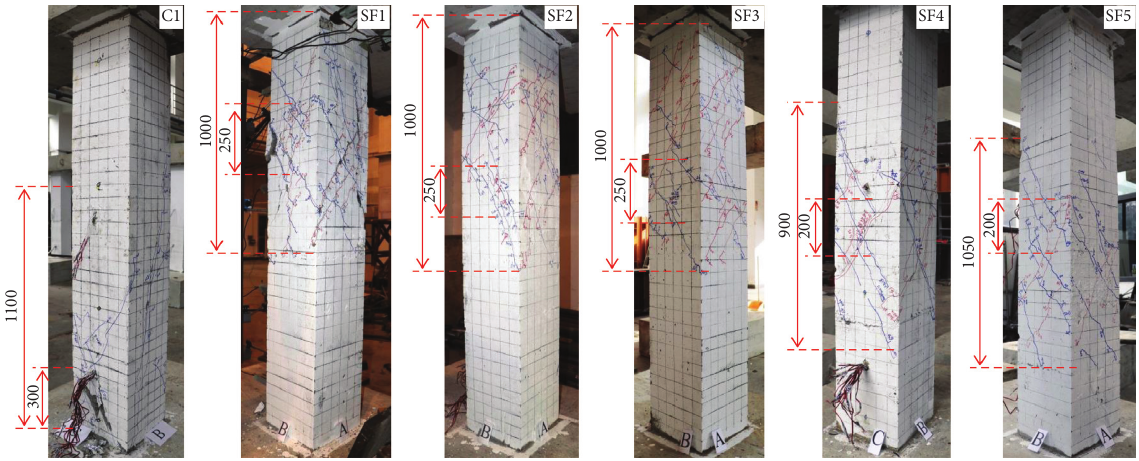
Figure 8: Crack propagation at the end of tests.